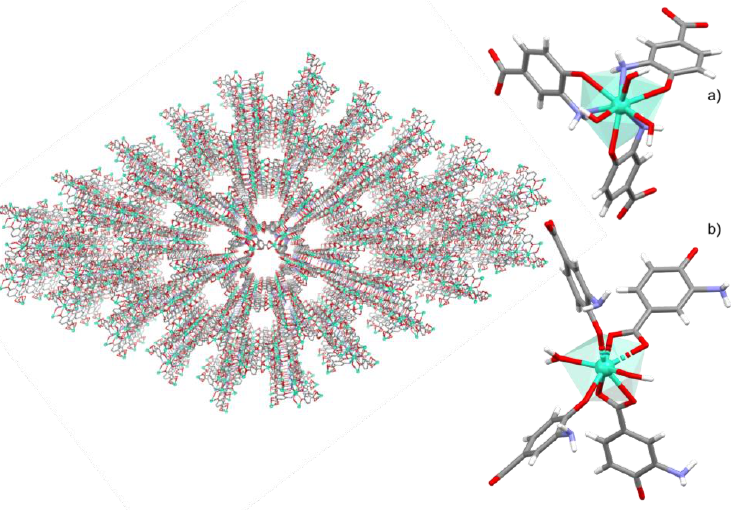
Figure 2. Packed structure of compound 1 (left) and ( a ) nine- and ( b ) eight-coordinated Tb environments found in the asymmetric unit of Tb-MOF.